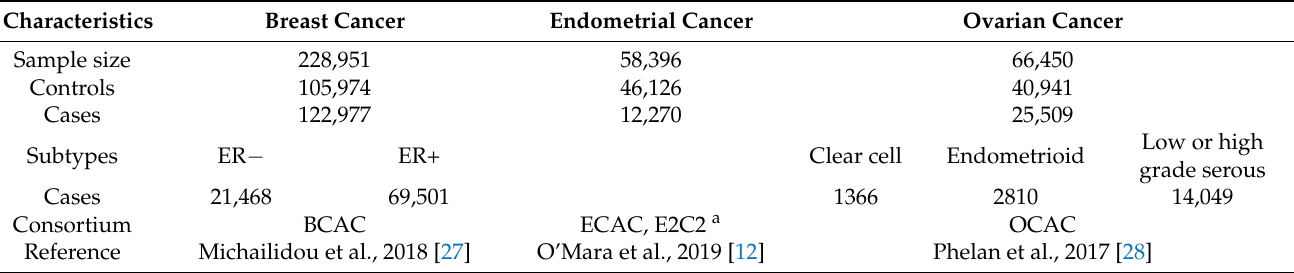
Table 2. Overview of genome-wide association studies used in the analyses for the outcomes.